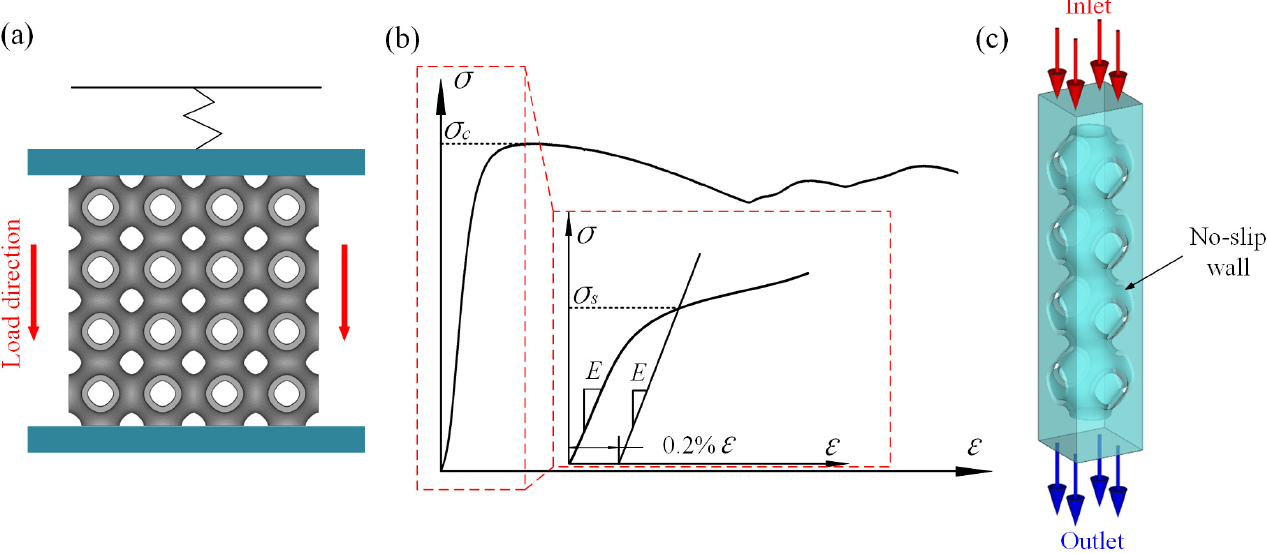
Figure 3. ( a ) Schematic diagram of compressive test; ( b ) schematic of elastic modulus and strength; and ( c ) boundary conditions for CFD analysis.